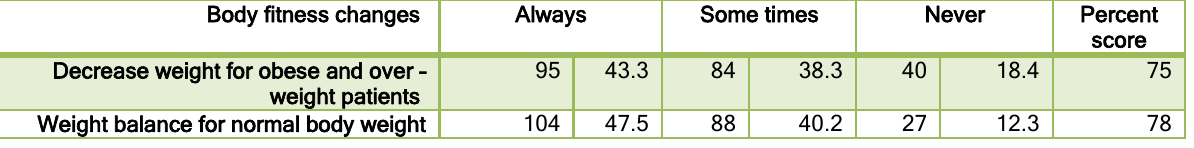
Table 5: Life style change related to body fitness and enough rest (N=219) Body fitness